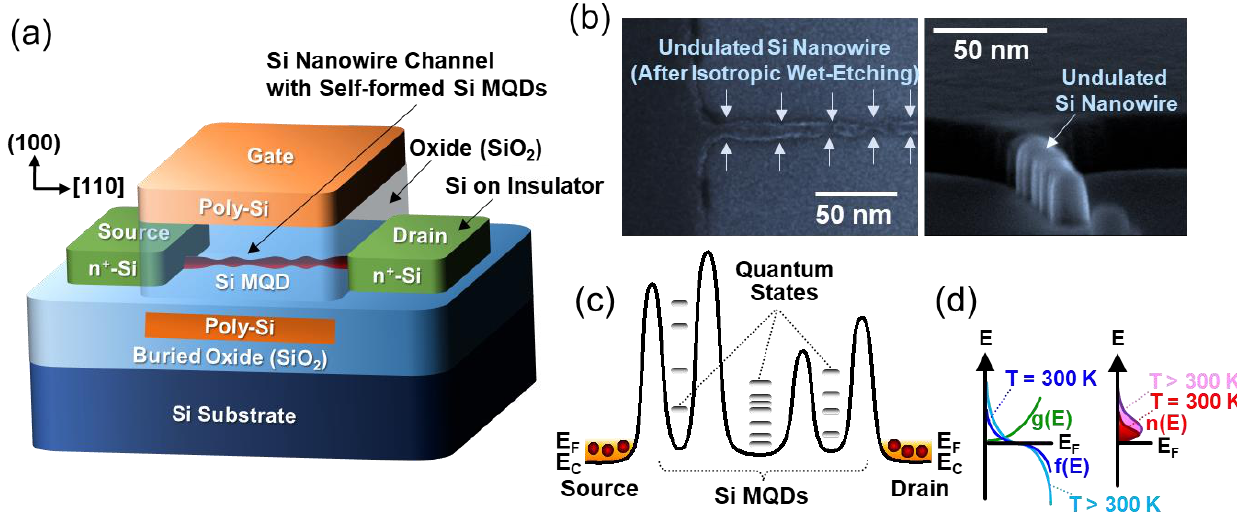
Figure 1. ( a ) Schematic of the fabricated SHT device, ( b ) scanning electron microscopy images (left, top view; right, tilted view) of the undulated Si nanowire channel obtained from dummy samples, ( c ) expected energy band diagram of the undulated Si nanowire-channel at the conduction band region, and ( d ) Fermi – Dirac distribution function, f(E) at T = 300 K and T > 300 K; density of state function, g(E); and electron distribution function, n(E) at T = 300 K and T > 300 K in the source and the drain reservoirs. In ( c , d ), Ec and E F denote the conduction band and the Fermi level, respectively.